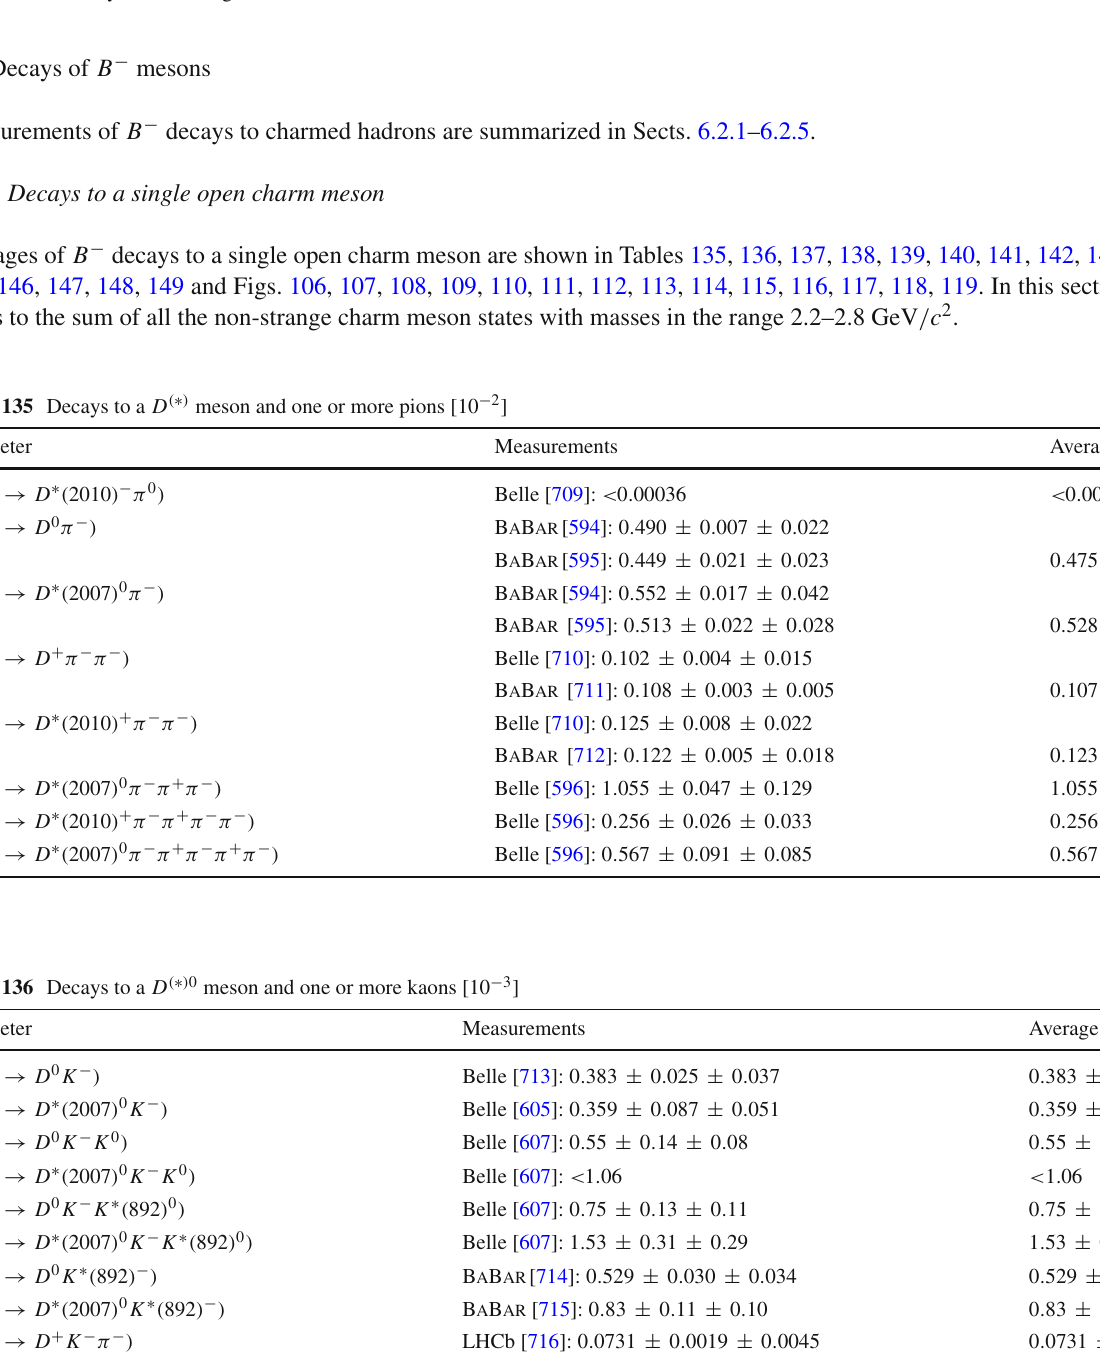
Fig. 105 Summary of the averages from Table